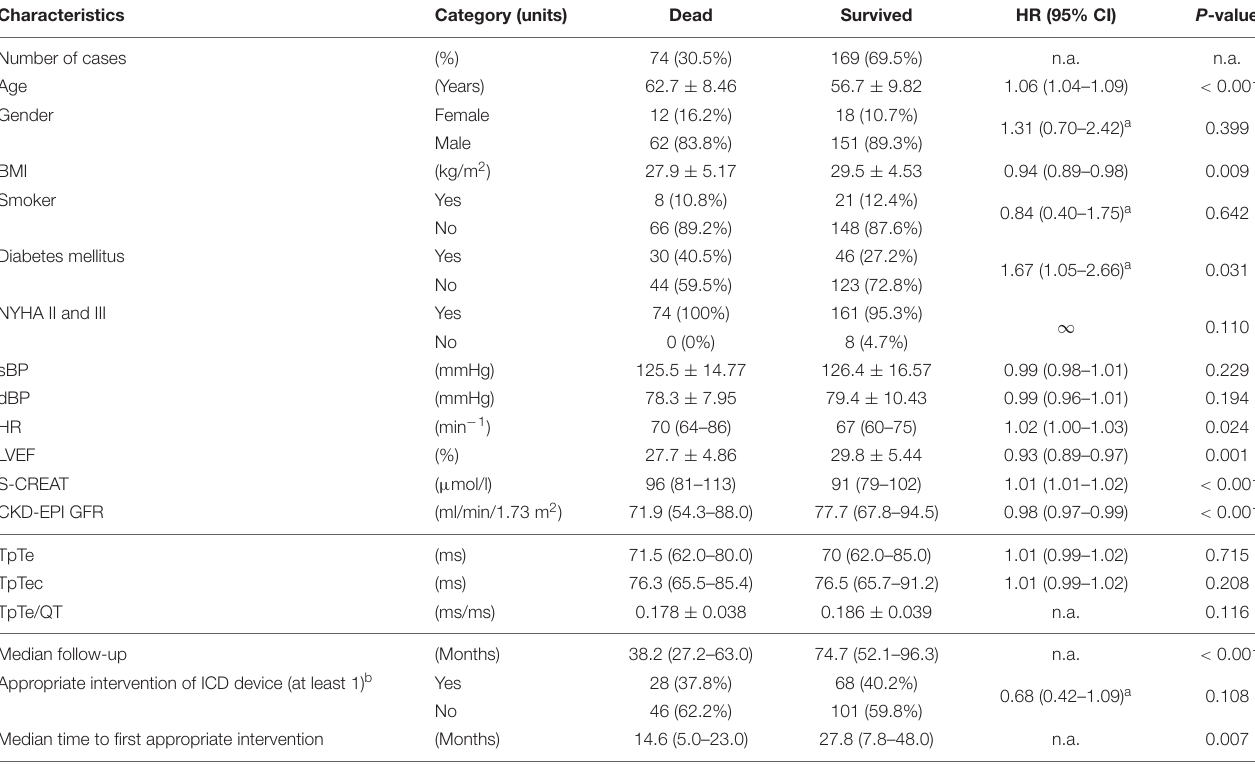
TABLE 2 | Clinical characteristics and follow-up data of patients grouped by overall survival. Characteristics